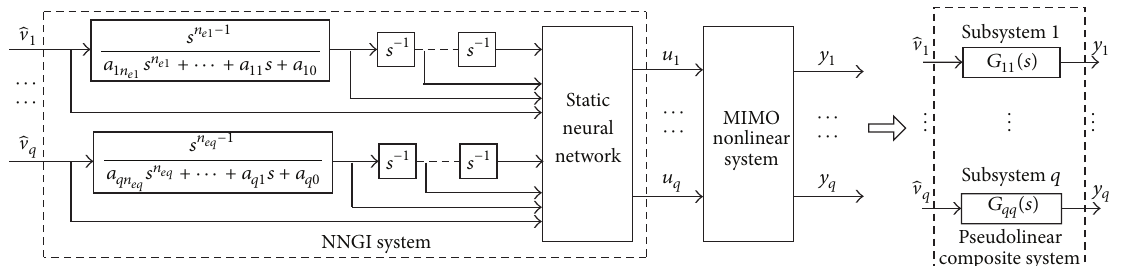
Figure 2: NNGI pseudolinear composite subsystem equivalent